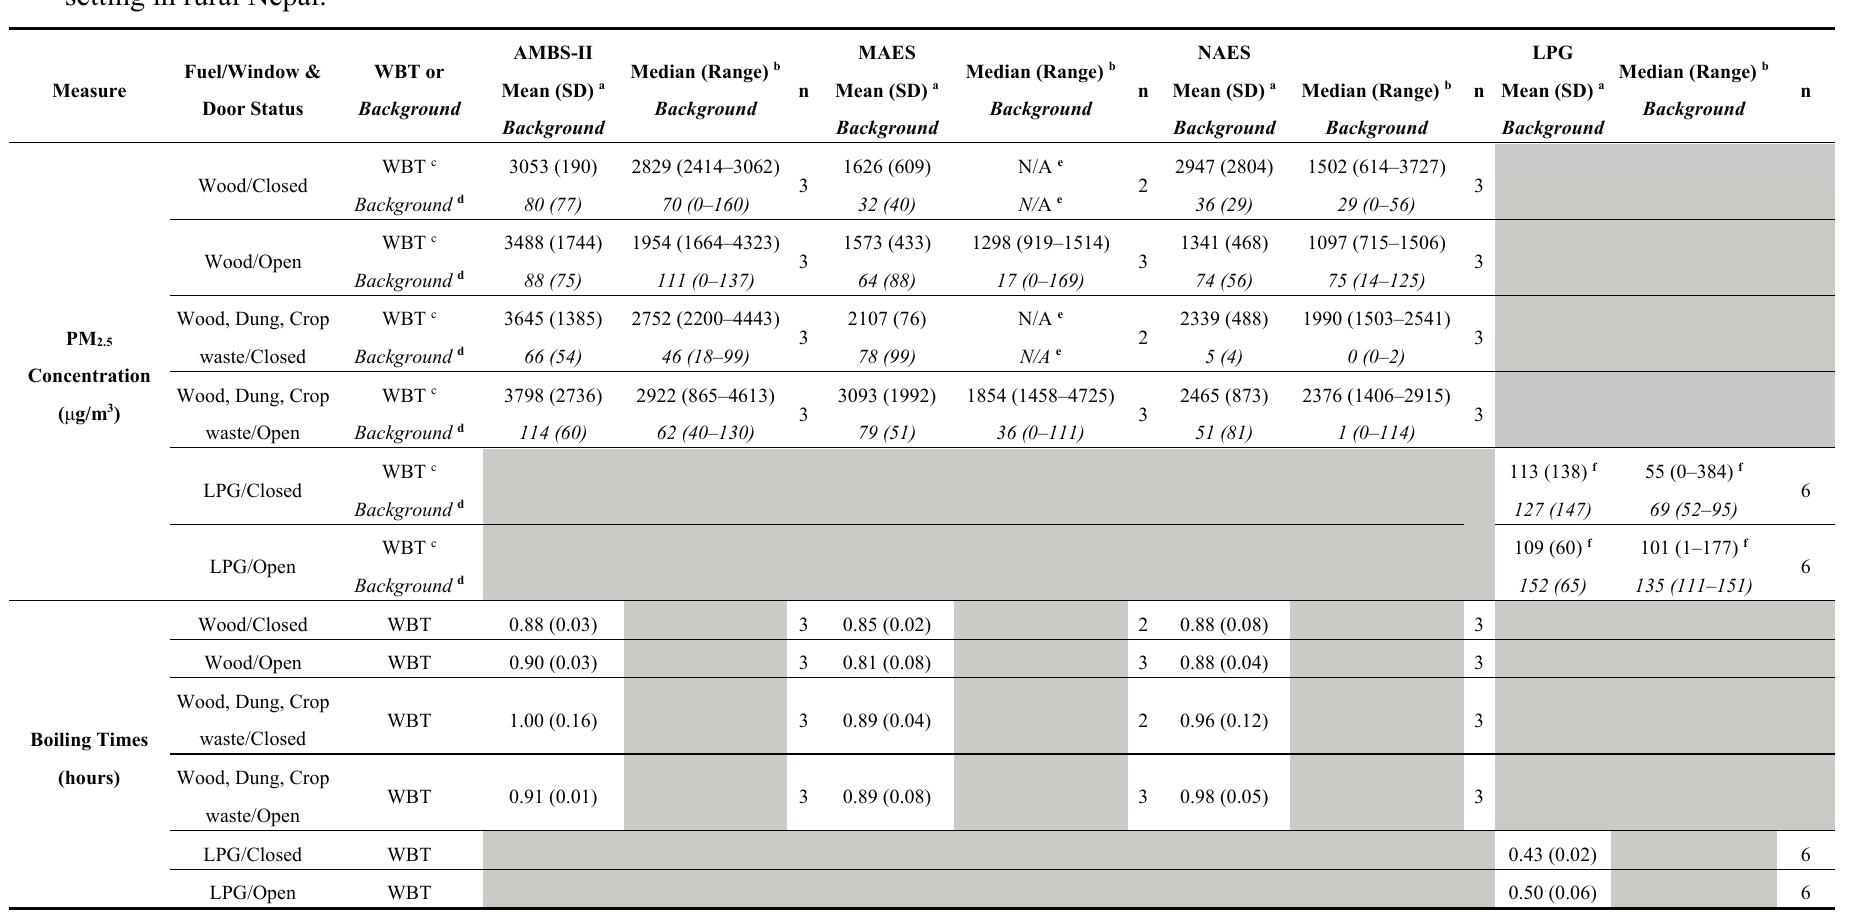
Table 4. Summary of cookstove performance in Study II comparing three alternative cookstoves with an improved brick stove in a home setting in rural